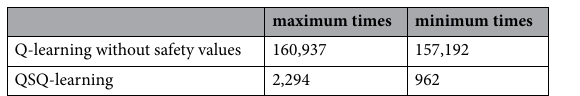
Table 1. The number of times the robot visits unsafe states during